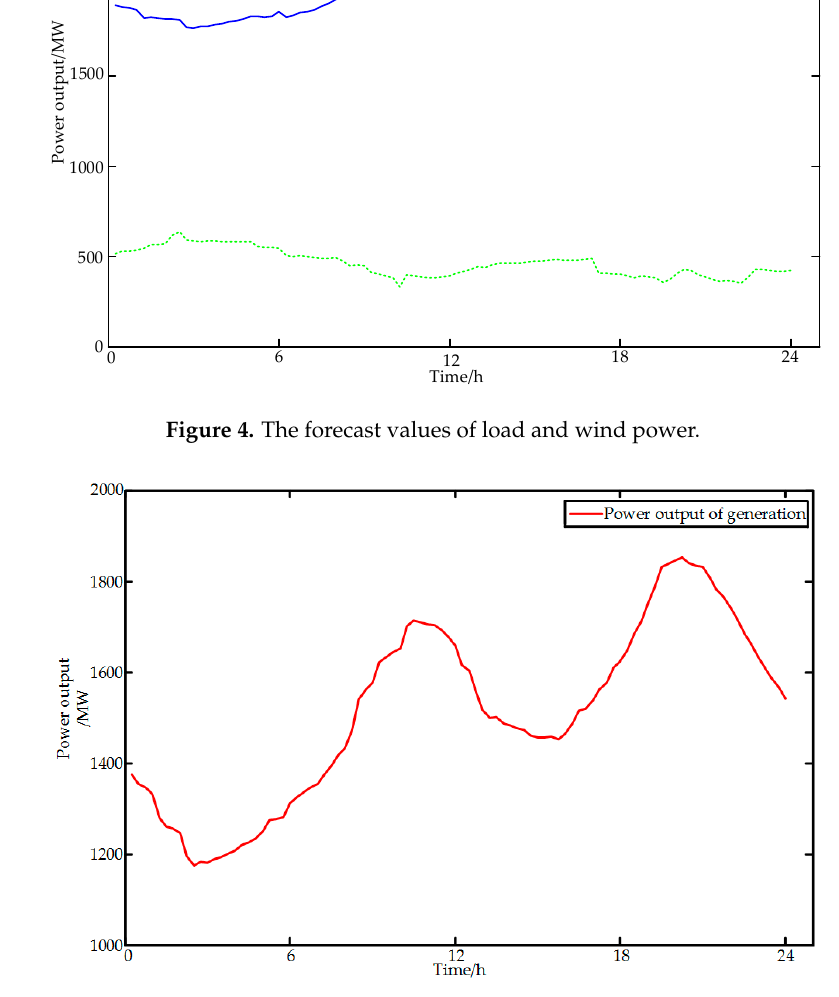
Figure 6. The required reserve for covering the risk.